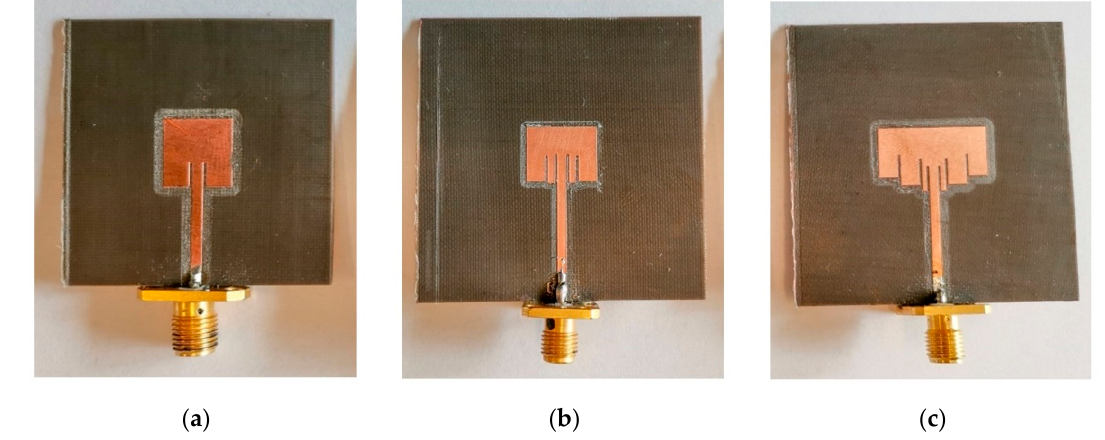
Figure 15. Microstrip patch antenna prototypes: ( a ) MPA1, ( b ) MPA2, ( c ) MPA3.